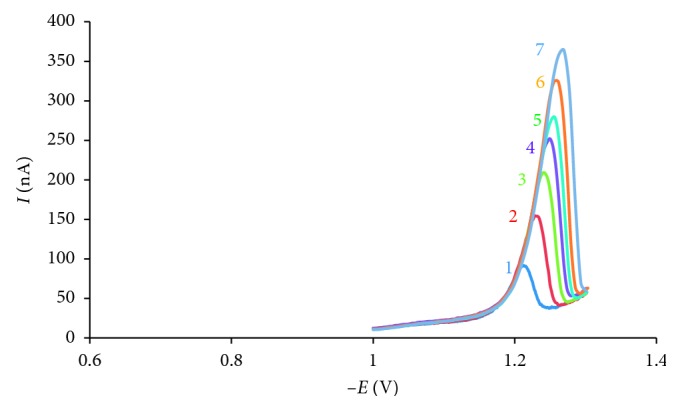
Voltammograms of 10−7 mol·L−1 AO in BR buffer depending on scan rate from 50 mV·s−1 to 400 mV·s−1 (1: 50 mV·s−1, 2: 100 mV·s−1, 3: 150 mV·s−1, 4: 200 mV·s−1, 5: 250 mV·s−1, 6: 300 mV·s−1, and 7: 400 mV·s−1), with conditions 10−7 mol·L−1 AO, pH = 9.0, tacc = 60 s, and f = 50 Hz.